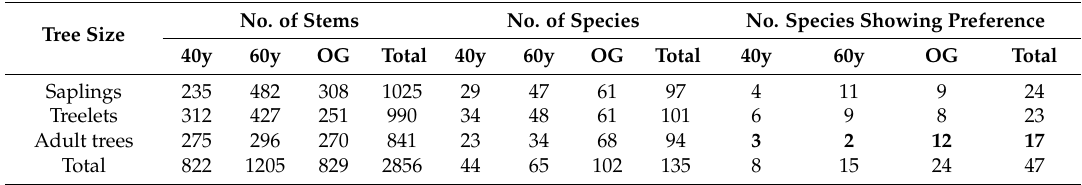
Table 1. Number of stems, species, and species showing a significant preference for different tree sizes. Tree Size